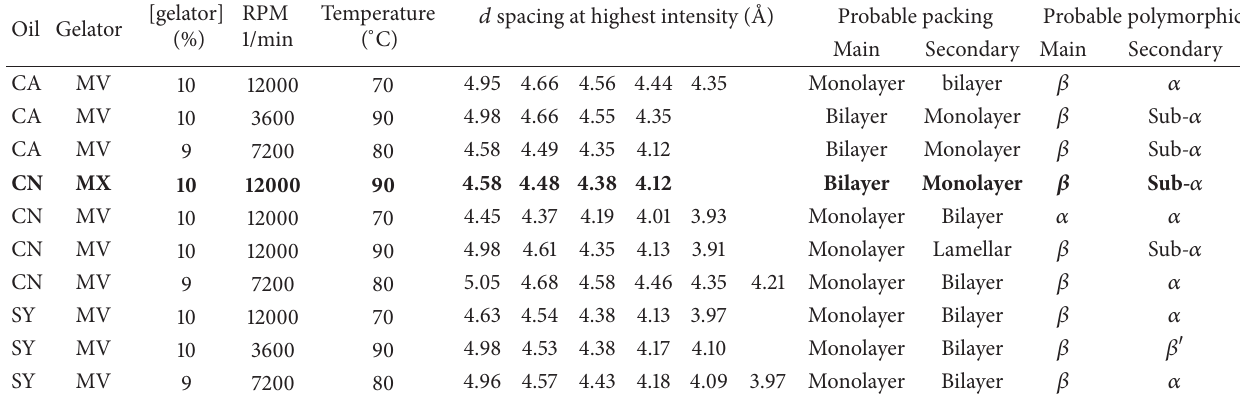
Table 2: Comparison of lattice spaces of experimental organogels.